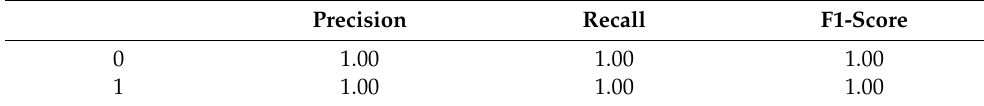
Table 10. Performance Metrics for Training Data.